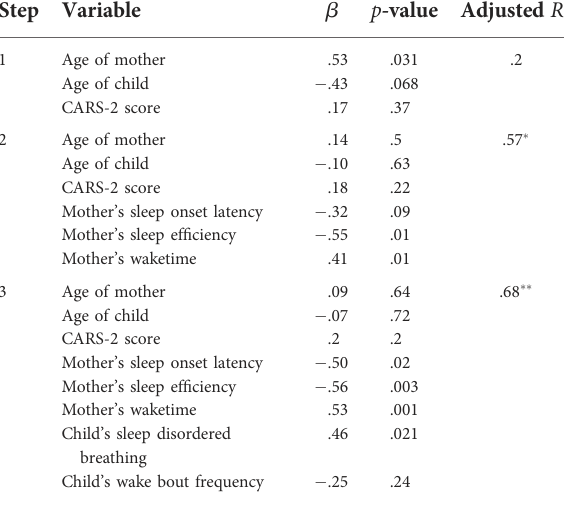
TABLE 9 Hierarchical multiple regression predicting Fragmentation Index in mothers.